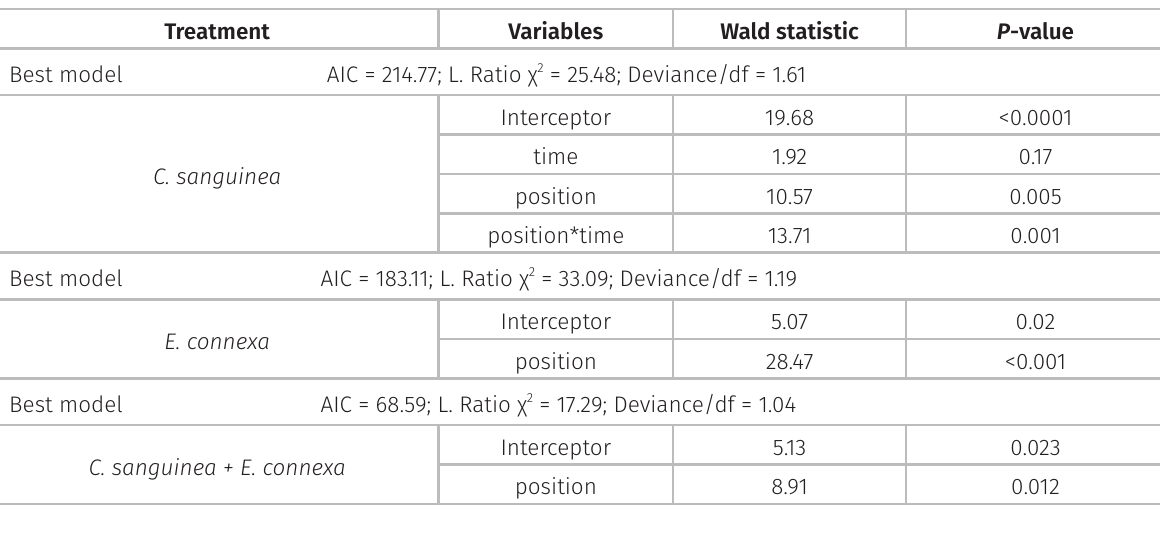
Table II. Results of the generalized linear model (GLM) for within-plant distribution of Cycloneda sanguinea and Eriopis connexa larvae after two and four days. For the conspecific treatments, a log-linear Poisson GLM was used, with the position of the larvae in the upper or lower stratum or outside the plant and the time, as the explanatory variables. For the heterospecific treatment, a binomial logistic GLM was performed, with the position of both species together (presence or absence) and time as the explanatory variables. The Akaike information criterion (AIC), likelihood ratio test (L. Ratio χ 2 ), and adjusted deviance (Deviance/df) are given for the best models fitted (in all instances, P <0.0001). The GLM-Wald statistics and P -values are